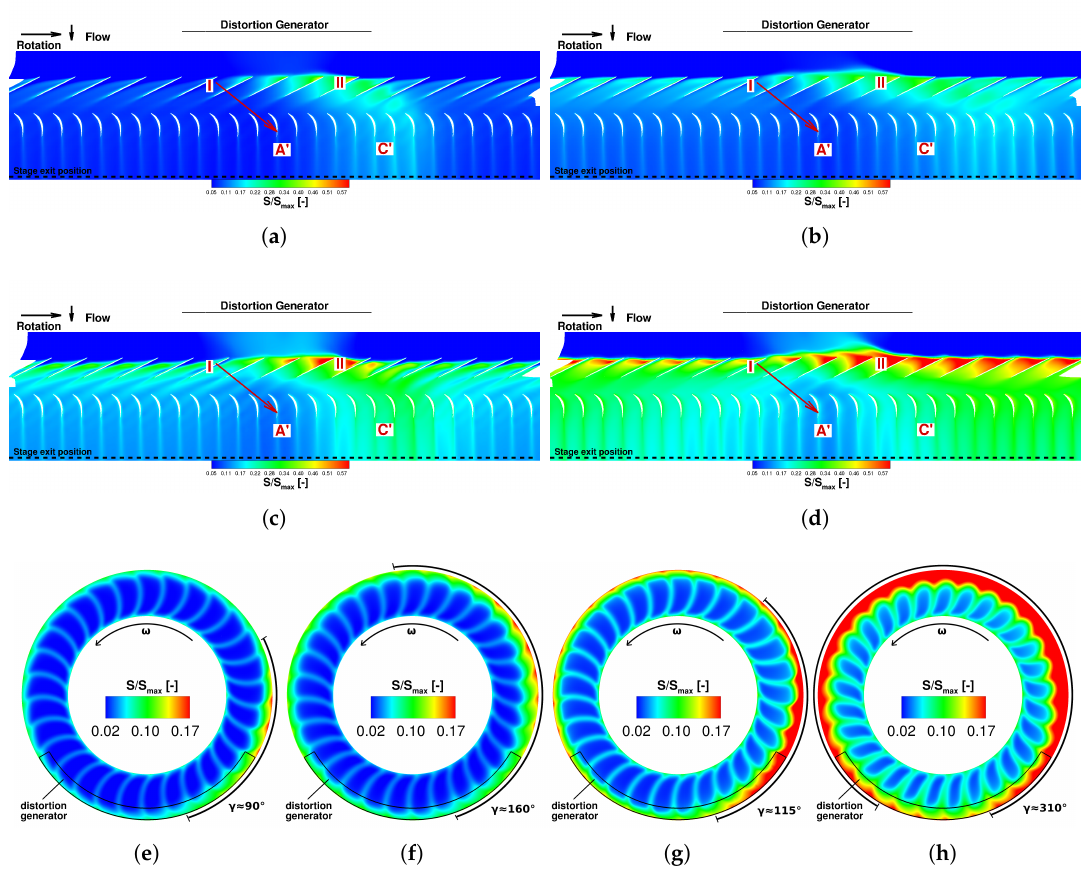
Figure 4. Entropy distribution. ( a ) N65, PE, 98% span; ( b ) N65, NS, 98% span; ( c ) N100, PE, 98% span; ( d ) N100, NS, 98% span; ( e ) N65, PE, stage exit; ( f ) N65, NS, stage exit; ( g ) N100, PE, stage exit; ( h ) N100, NS, stage